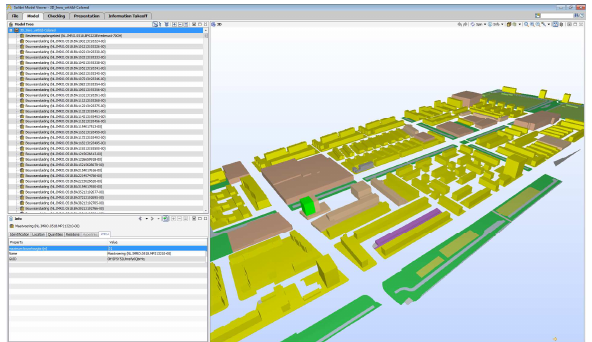
Figure 3. 3D spatial plan converted into IFC and viewed in Solibri Model